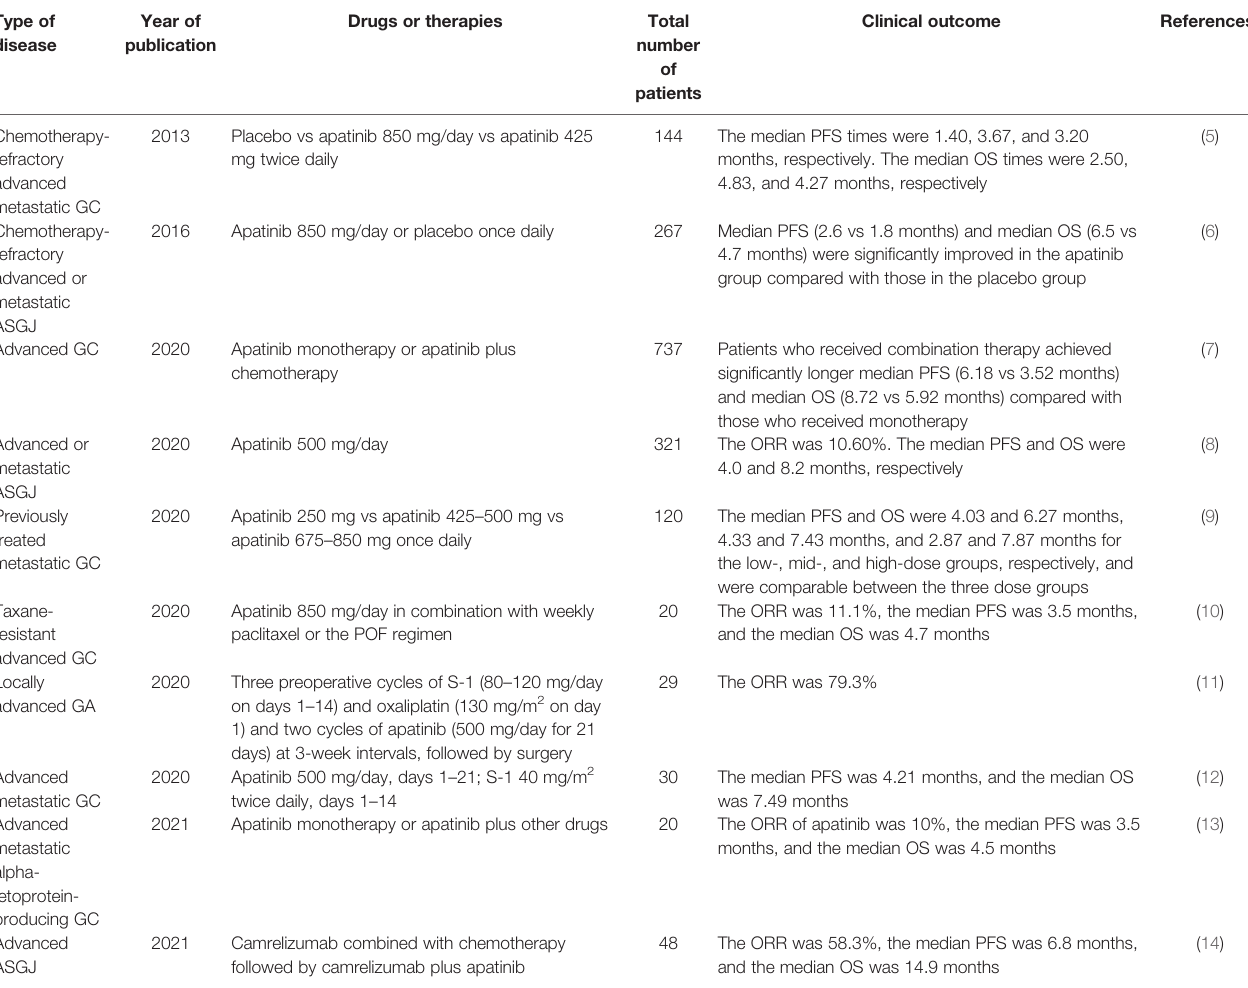
TABLE 1 | Clinical trials on apatinib treatment for GC included in this